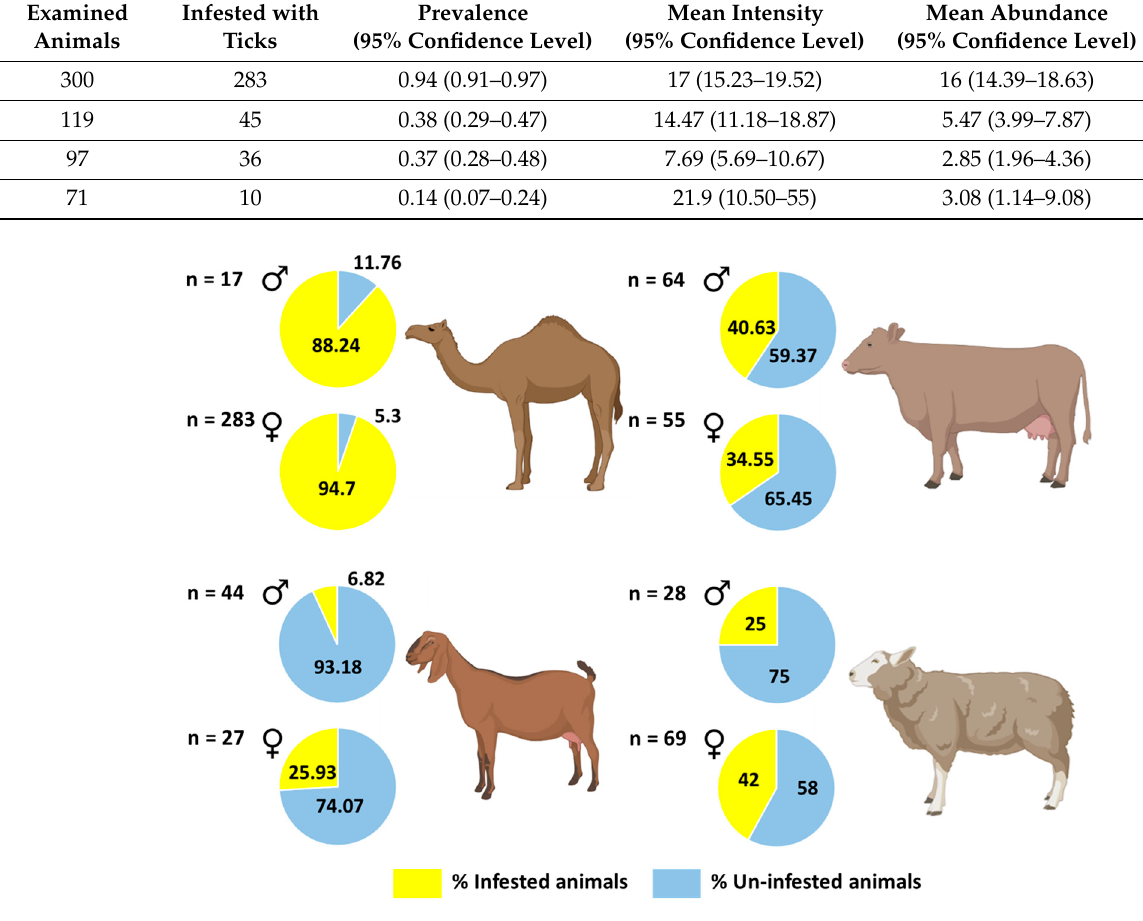
Figure 6. Prevalence of ticks per host (camel, cow, goat, and sheep) in relation to the sex of hosts, in 2019, 2020 and 2021, in the United Arab Emirates. The figure was created with BioRender (https://bi- orender.com/) (accessed on 4 August 2021).